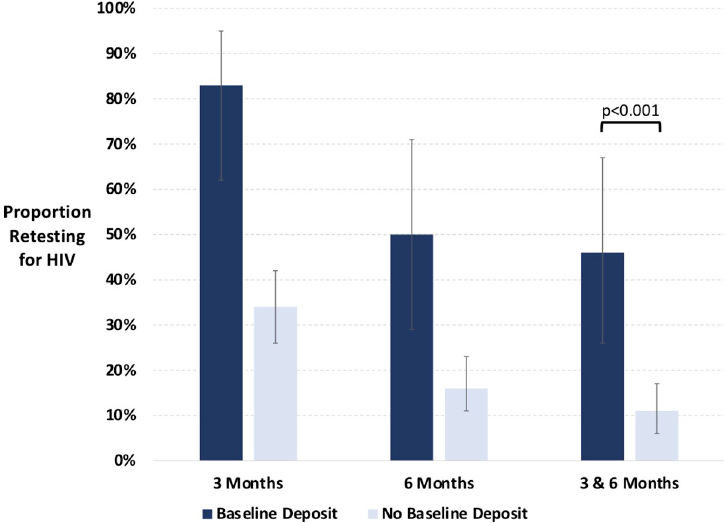
Fig 4. The proportion of participants (with 95% confidence intervals) retesting for HIV at 3 months, 6 months, and both 3 and 6 months within the deposit contract group, stratified by those who did or did not make a baseline